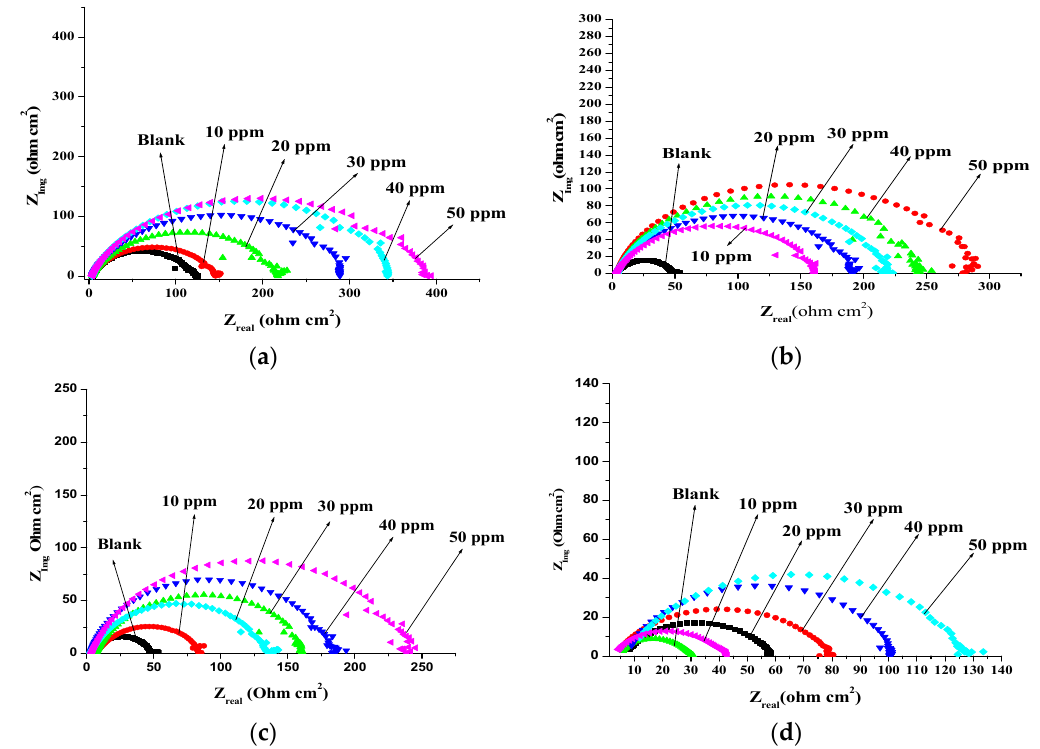
Figure 9. The Nyquist graphs of soft-cast steel without and with the various concentrations of olmesartan in 1 mol dm − 3 HCl at temperatures of ( A ) 303 K, ( B ) 313 K, ( C ) 323 K, and ( D ) 333 K.